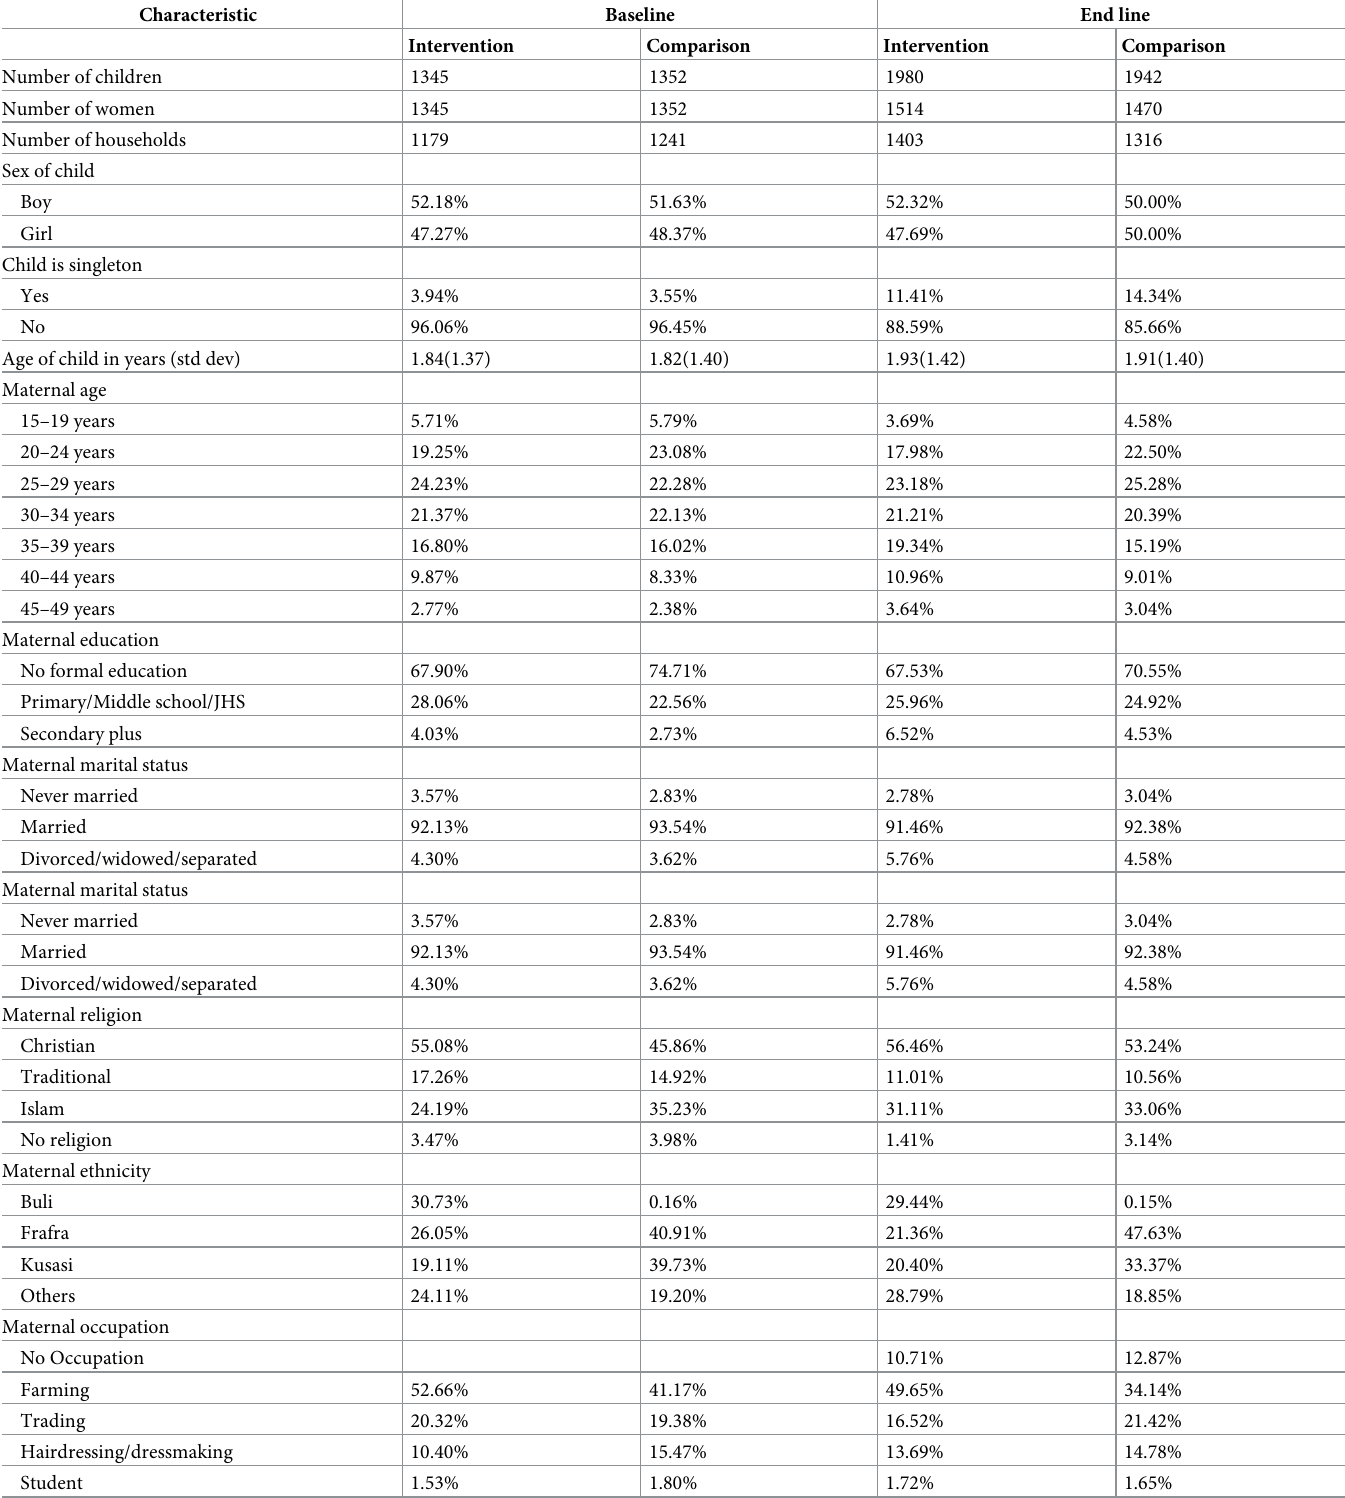
Table 1. Descriptive